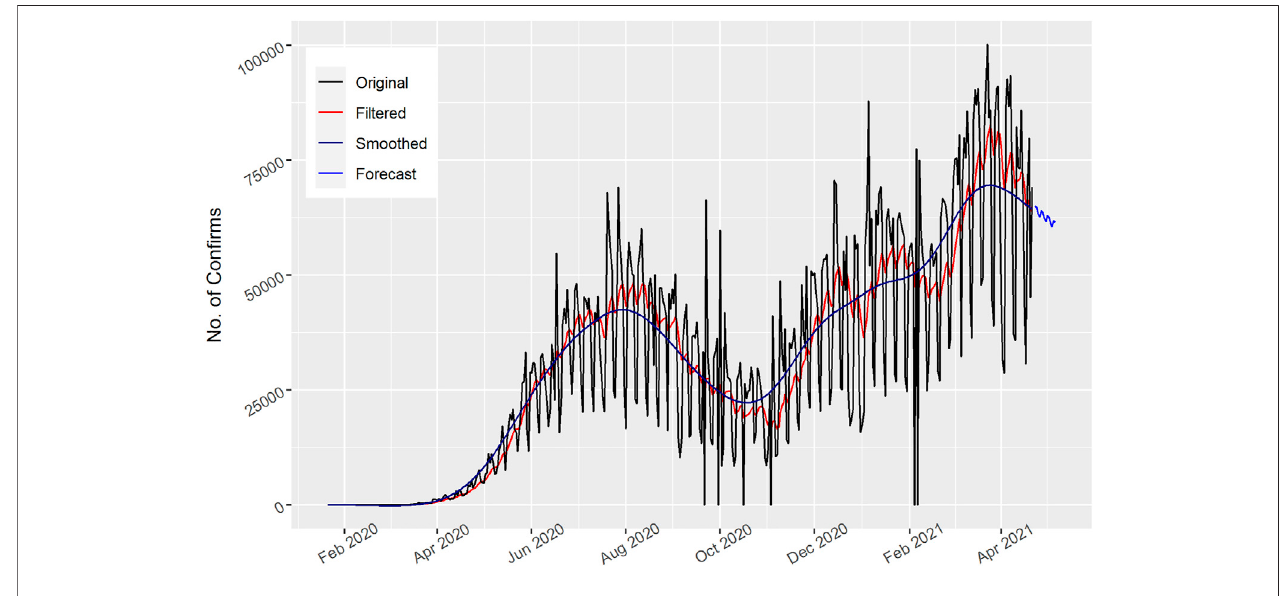
FIGURE 3 | Number of daily Con fi rmed cases in Brazil.